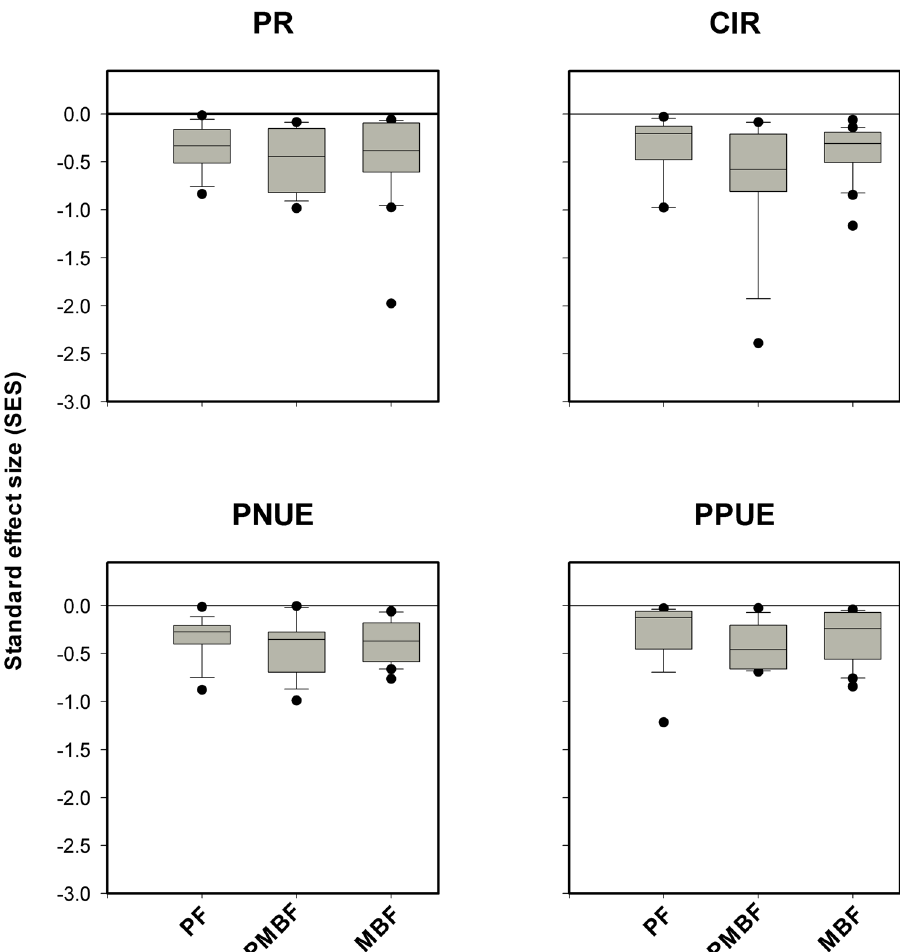
Figure 2. Values of standard effect size (SES) in three forest successional stages (Pine forest (PF), pine and mixed broadleaf forest (PMBF), and matured broadleaf forest (MBF)), obtained using 1000 communities simulated under a null model. SES > 0 represents trait divergence, SES < 0 indicates trait convergence and SES = 0 implies neither trait convergence nor divergence. The solid line inside the box represents the median of the data. The bottom and top of the box represent the 1st quartile and 3rd quartile of the data, respectively. The vertical lines extending from the box represent the data inside a range of 1.5 times the interquartile range from the box. An outlier is denoted by filled